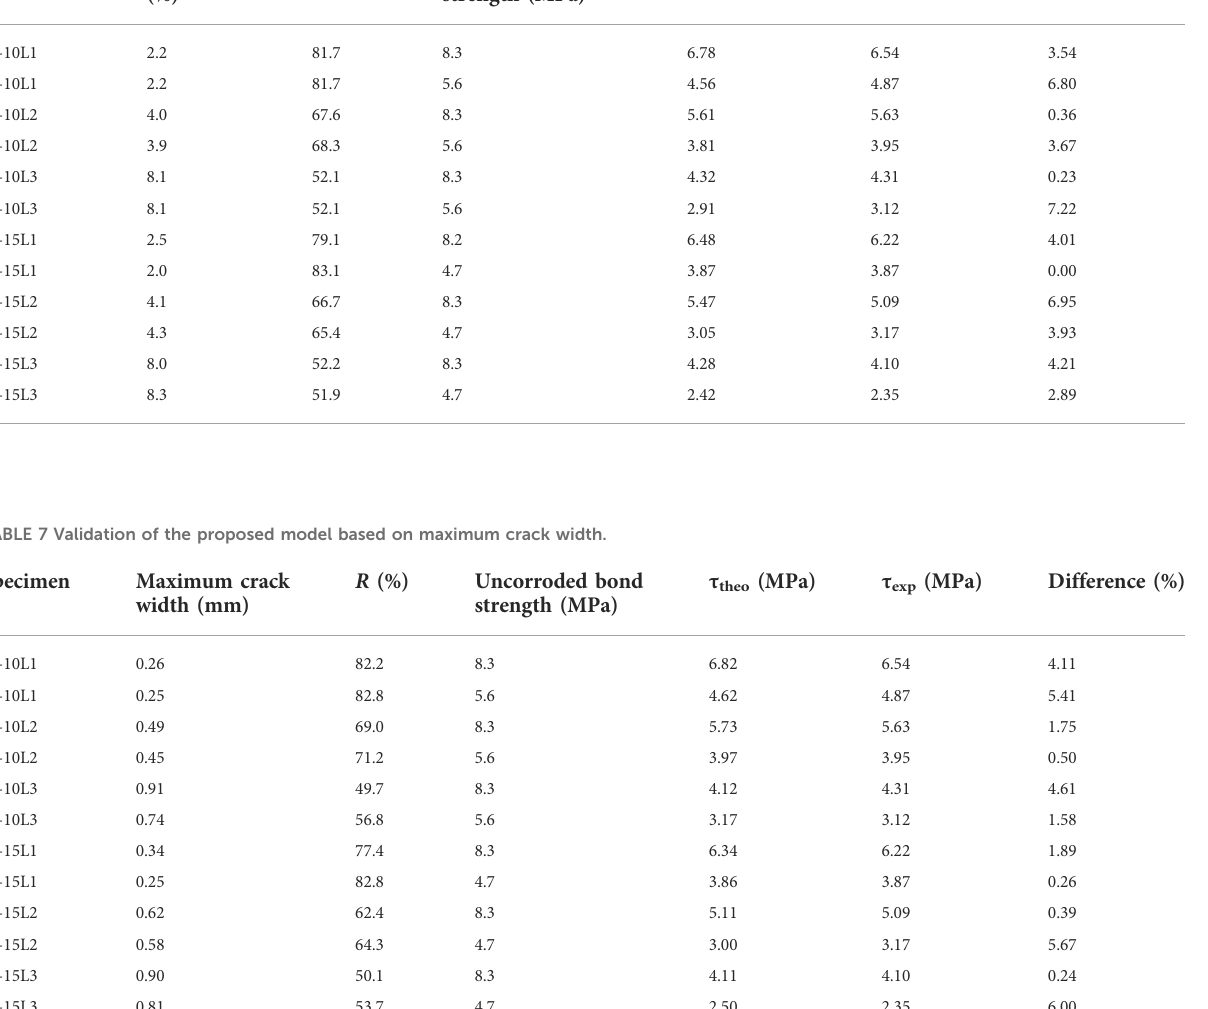
TABLE 6 Validation of the proposed model based on steel mass loss. Specimen